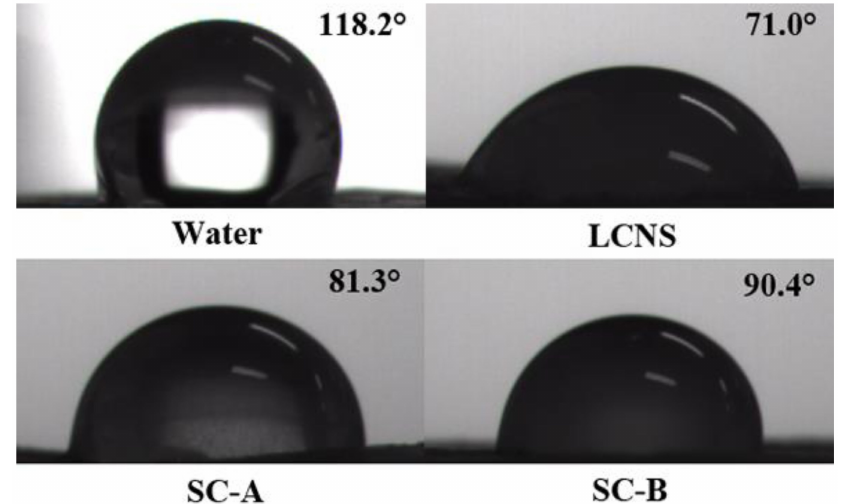
Figure 4. Contact angle image of different lambda-cyhalothrin formulations on brassica oleracea leaves.